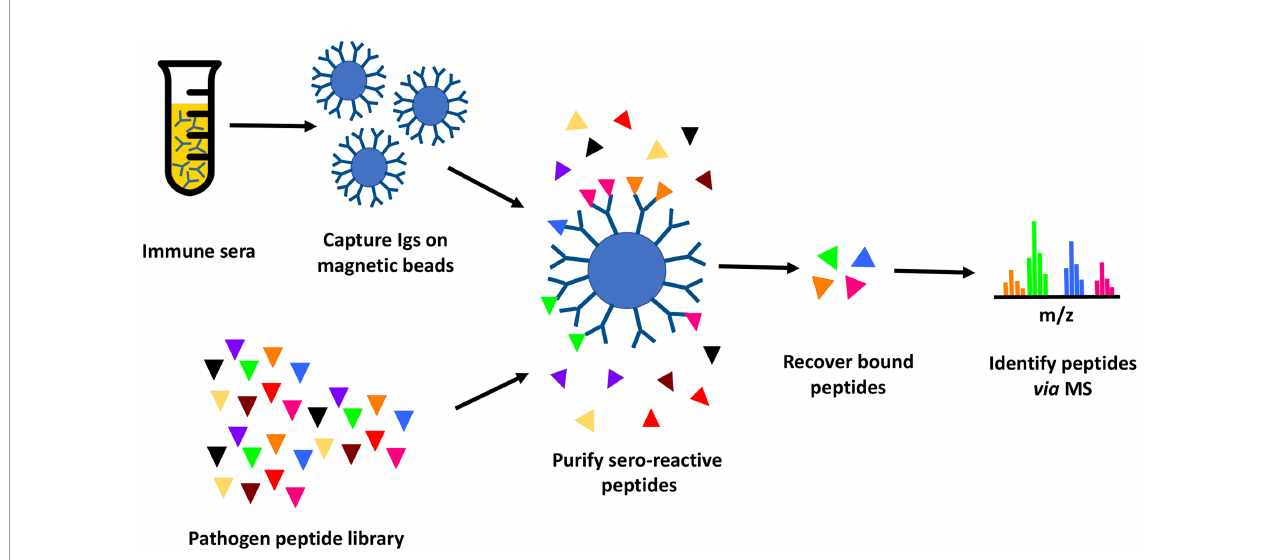
FIGURE 1 | Immunoproteome screening work fl ow. Schematic overview of high throughput approach for identi fi cation of seroreactive peptides in the proteomes of